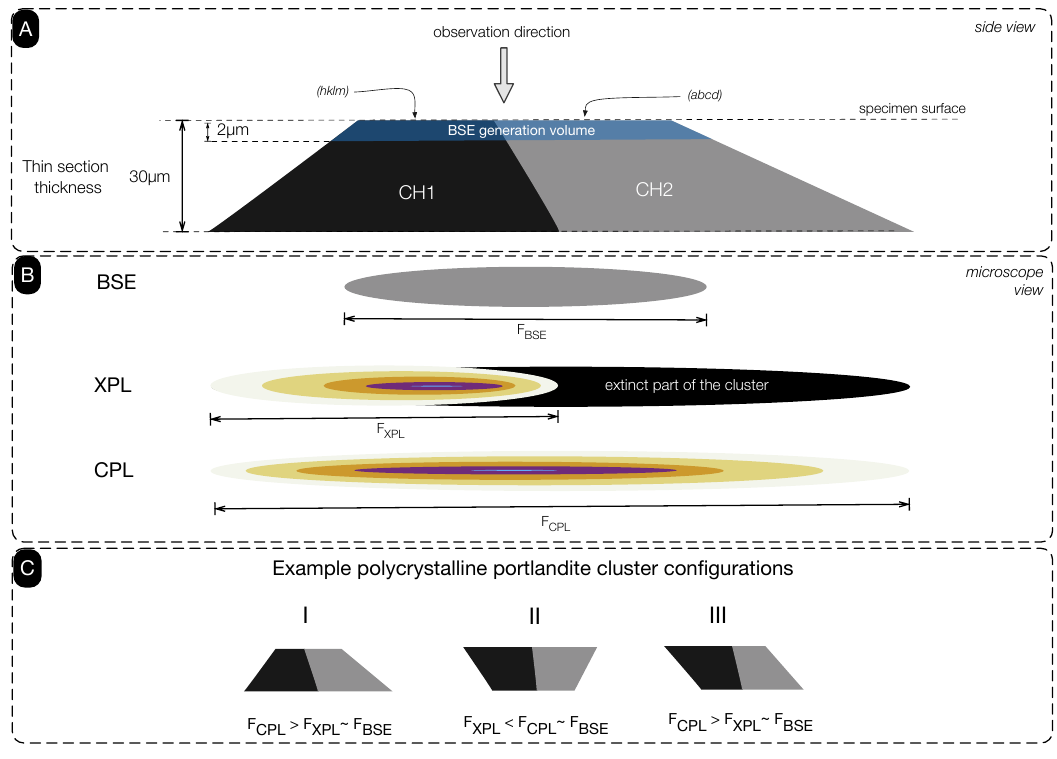
Figure 8. ( A ) Appearance of a hypothetical portlandite cluster with two adjacent crystals (Type I), side view in a 30- µ m section; ( B ) Rendition of the cluster under SEM-BSE, XPL and CPL modes as observed by the microscopist; ( C ) Example polycrystalline portlandite cluster configurations found in portland cement